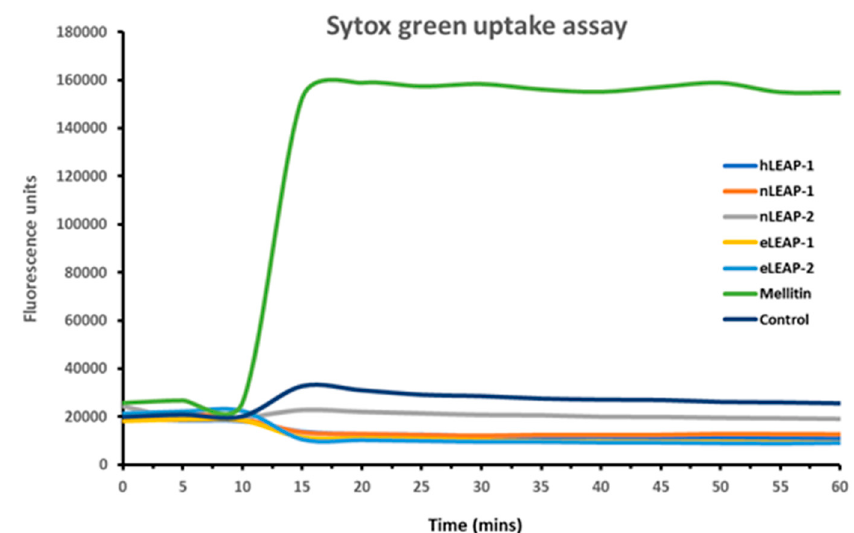
Figure 3. Kinetics of S. aureus membrane permeabilization caused by the LEAPs at 2 × MIC. The positive control (melittin) is also shown to provide maximal permeabilization values. S. aureus cells suspended in 5 mM HEPES, 20 mM glucose, and 100 mM KCl (pH 7.4) were incubated with 5 µM SYTOX Green and LEAPs. Modifications of the membrane by peptides allow the SYTOX green dye to enter the bacterial cell and bind DNA, resulting in fluorescence signal increase. Fluorescence of SYTOX green dye was monitored, at an excitation wavelength of 485 nm and an emission wavelength of 520 nm.